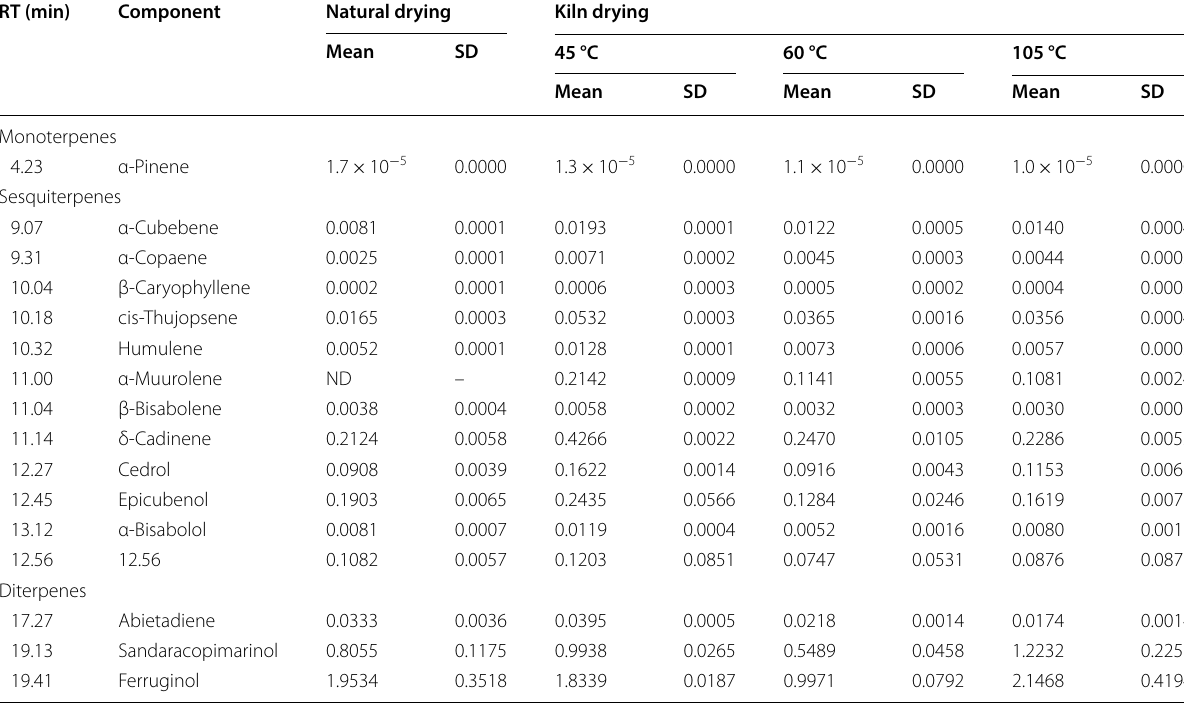
Data are expressed as the ratio of the peak area of each component to that of naphthalene. n ND not detected